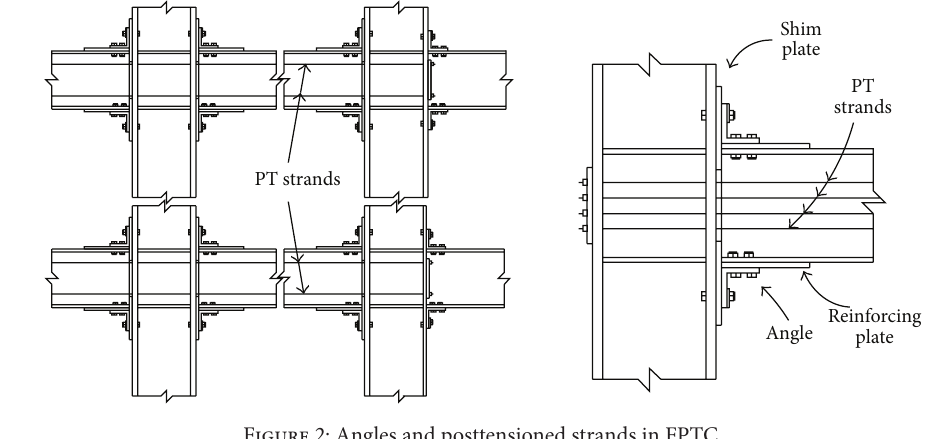
Figure 2: Angles and posttensioned strands in FPTC.